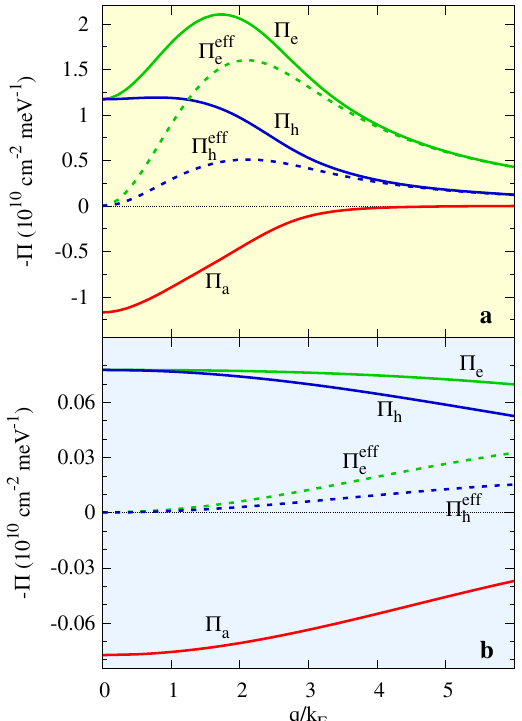
Fig. 3 Polarizabilities. The green (blue) solid lines are the normal electron (hole) polarizabilities in the presence of the super fl uid Π Π e ( q ) ( h ( q )). The red solid lines are the anomalous polarizabilities Π fl uid electron – hole pairs. Dashed green and a ( q ) for the super blue lines are the corresponding effective polarizabilities ð q Þ (cid:6) Π ð q Þ þ Π ð q Þ . a For density n ≃ n Π eff e ; h a e ; h in the BCS – BEC crossover regime. b For density n = 0.5 × 10 10 cm − 2 in the BEC